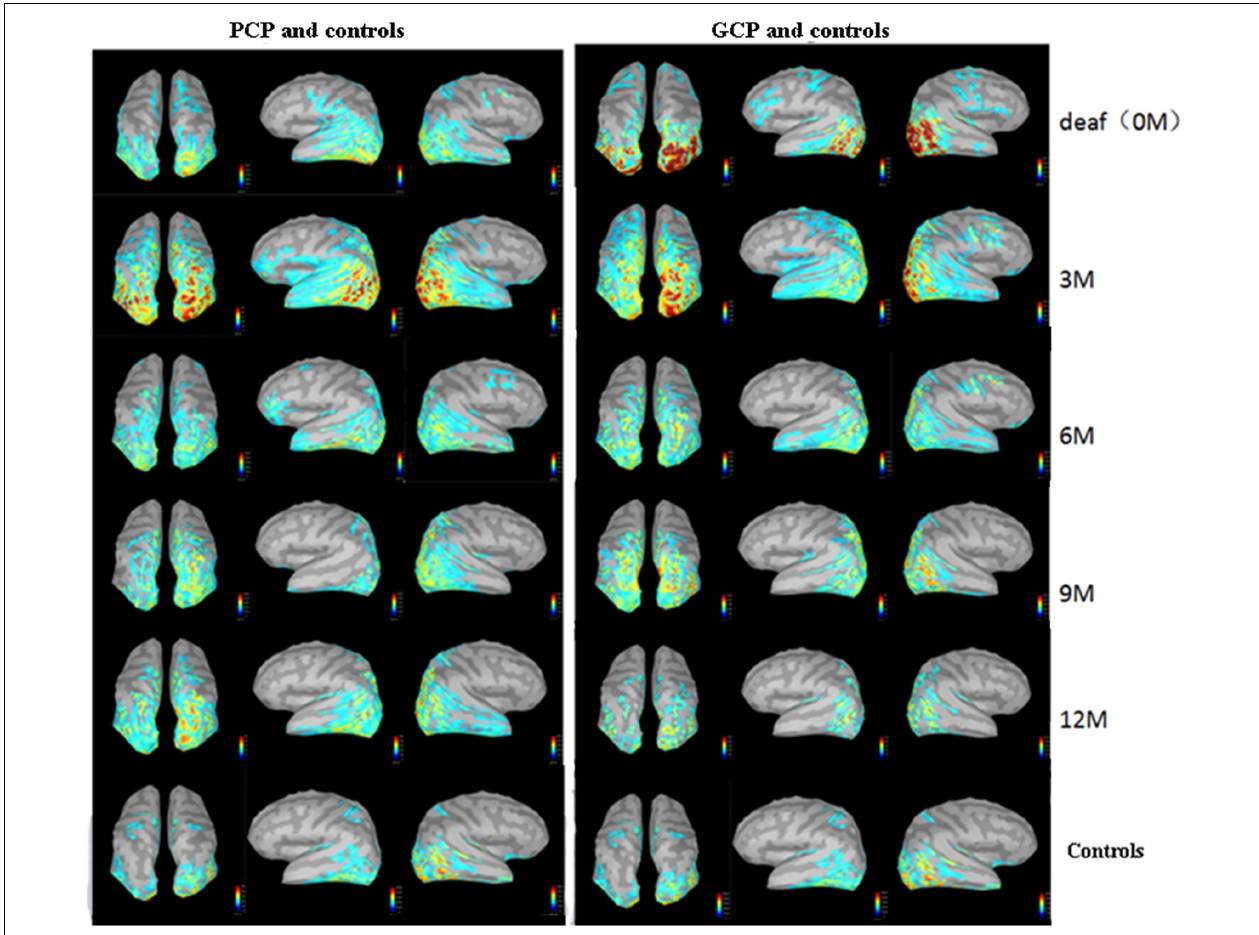
FIGURE 3 | Temporal evolutions of group-averaged cortical changes of the N1 component in deaf children pre-and post-CI and cortical activation in controls. The (left) part shows cortical-activated evolution of PCP and controls, while the (right) one shows those of GCP and controls. The last row shows cortical activation in normal